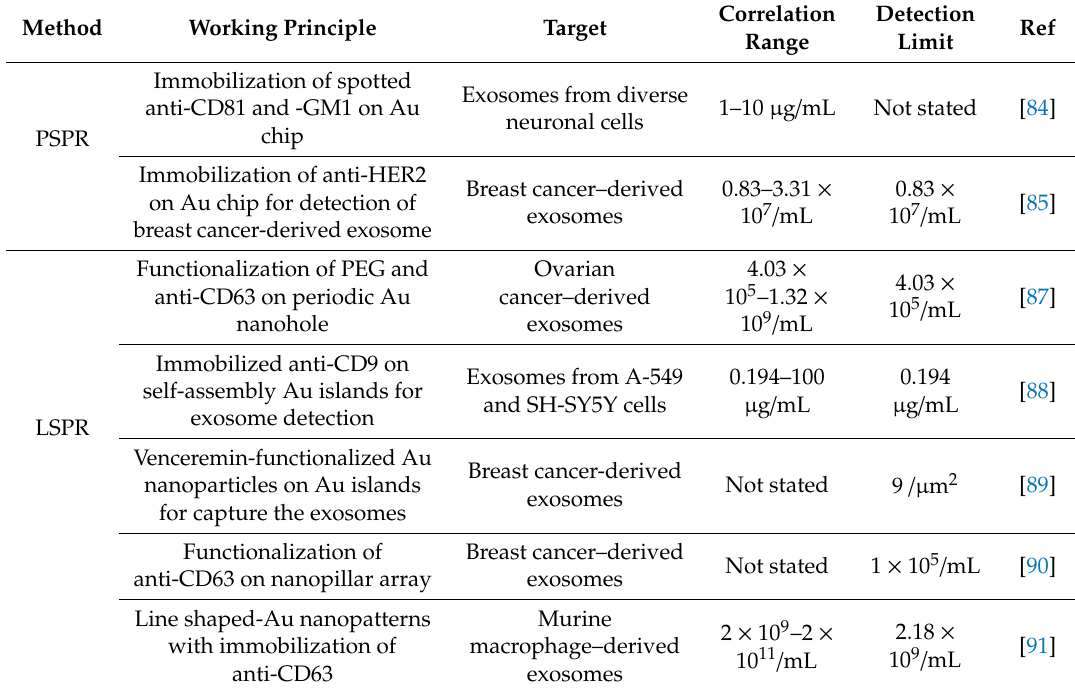
Table 4. Comparison of SPR and LSPR-based immunosensors for exosome